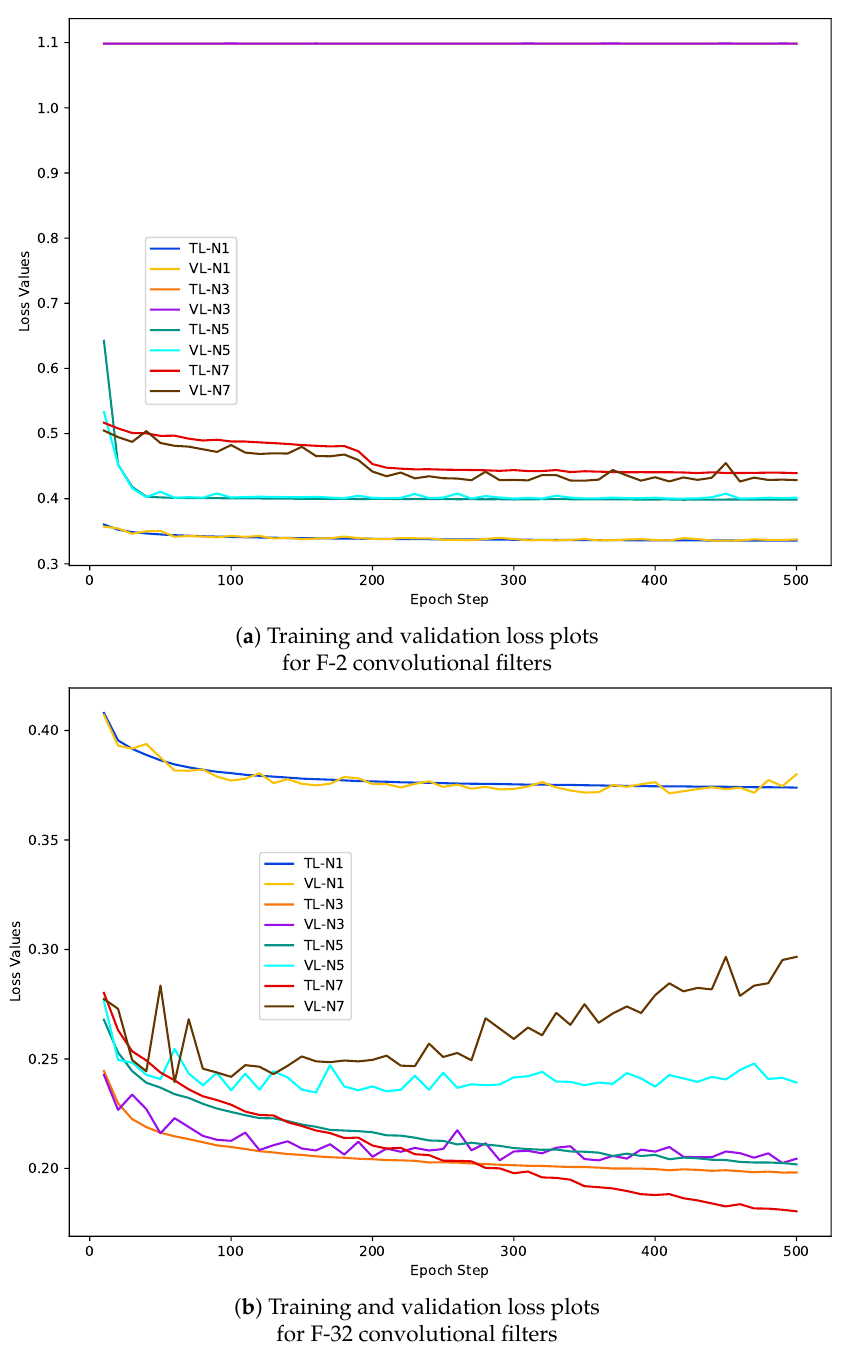
Figure 8. Training and validation loss plots of model networks with combinations of different numbers of convolutional filter and different sets of training sample. The number of learnable filters used to the model is specified as ‘F-number’ in every sub-caption. TL and VL in legends denote training loss and validation loss. Neighbourhood size is depicted as